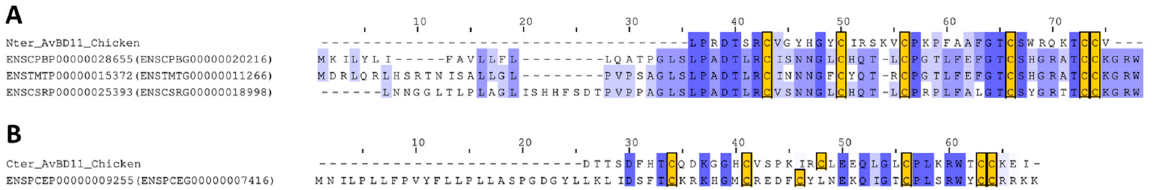
Figure 7. Alignments of the N-terminal ( A ) and C-terminal ( B ) domains of chicken AvBD11 with turtle homologs identified by BLAST. The MSA was performed with MAFFT and drawn with Jalview with a blue colour gradient (100% of identity for dark blue). Conserved cysteine residues are highlighted in yellow boxes.